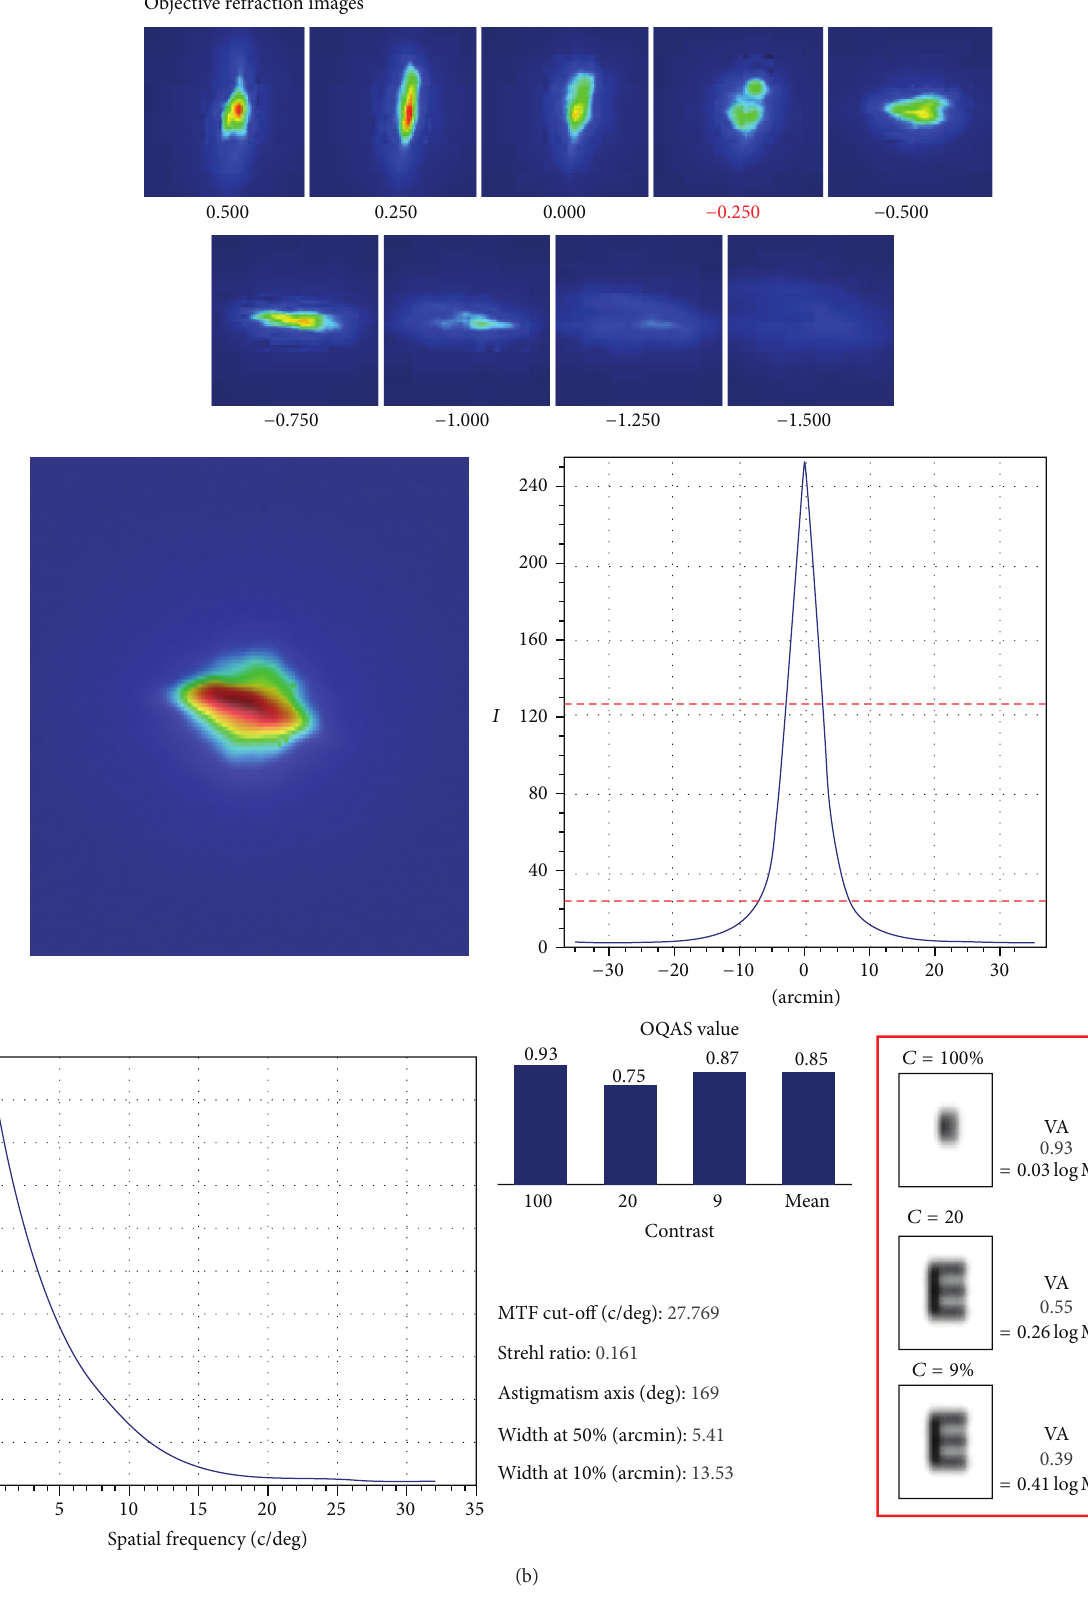
Figure 2: Representative OQAS results of (a) normal and (b) pseudophakic eyes. The red rectangles show Sim VA (simulated visual acuity) at different simulated contrast